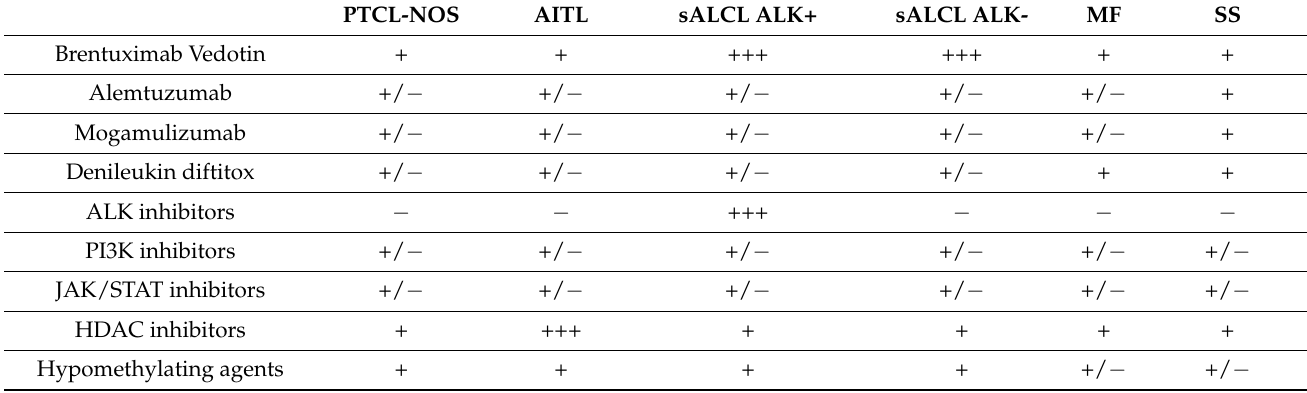
Table 2. Targeted T-cell therapy by T-cell lymphoma subtype. +++ Data available suggesting particular benefit; +